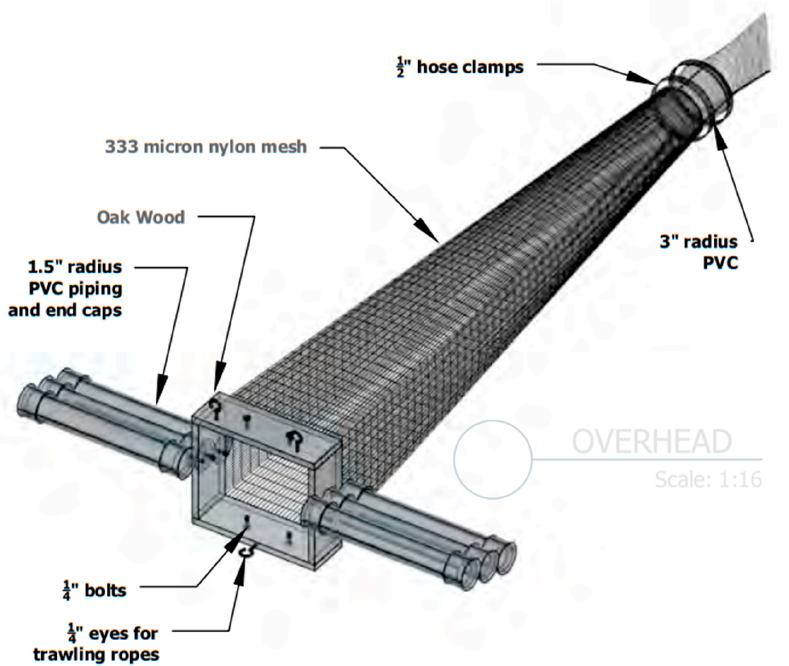
Figure 1. Conceptual drawing of LADI (CLEAR, 2016) .